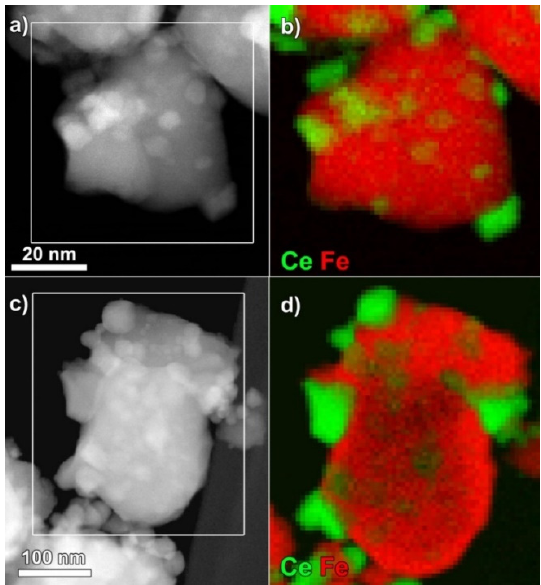
Figure 8. ( a ) Image of calcined 80 wt% Fe 2 O 3 -CeO 2 via high angle annular dark field scanning TEM (HAADF -STEM), ( b ) corresponding EELS map for Fe and Ce, ( c ) image for cycled 80 wt% Fe 2 O 3 -CeO 2 (100 H 2 –CO 2 redox cycles) and ( d ) corresponding EELS map for Fe and Ce [54].